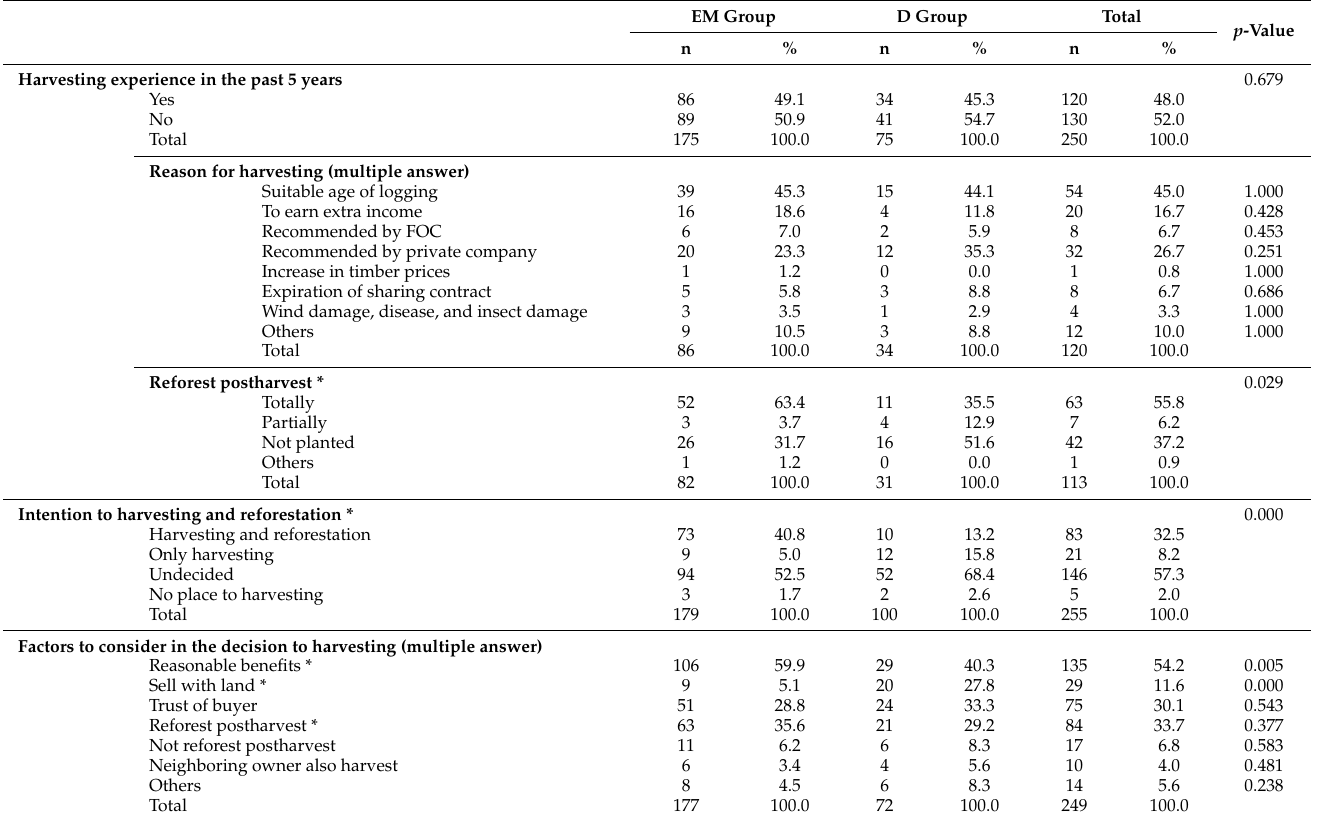
Table 11. Comparison of reasons for harvesting/reforestation and harvesting decisions between the two groups in